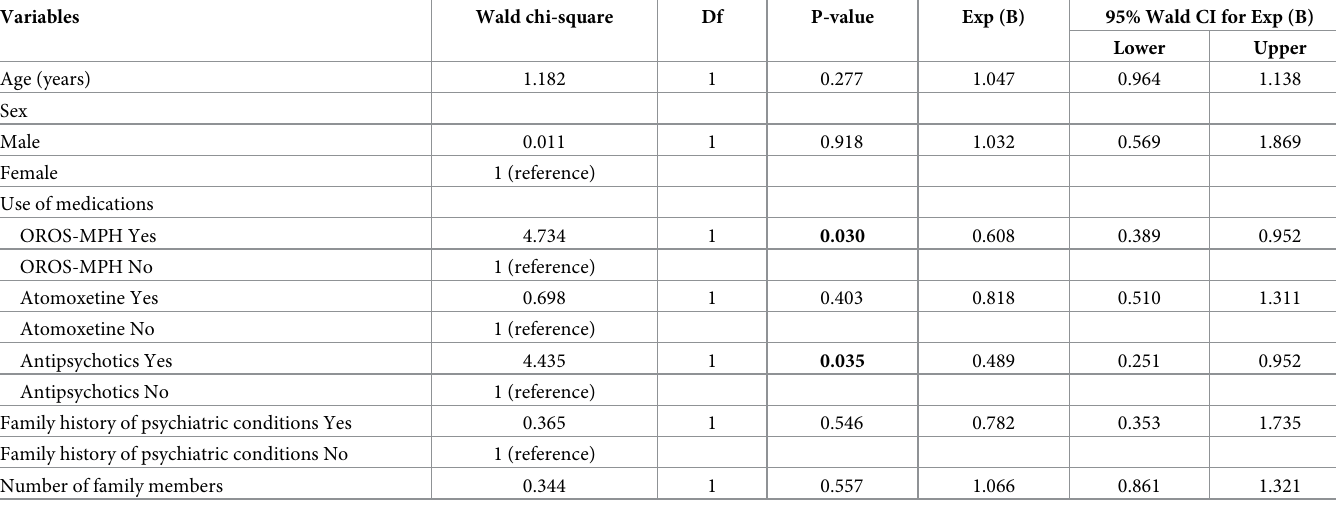
Table 4. Association between characteristics and cancellation rate in the AD/HD patients included in this study.